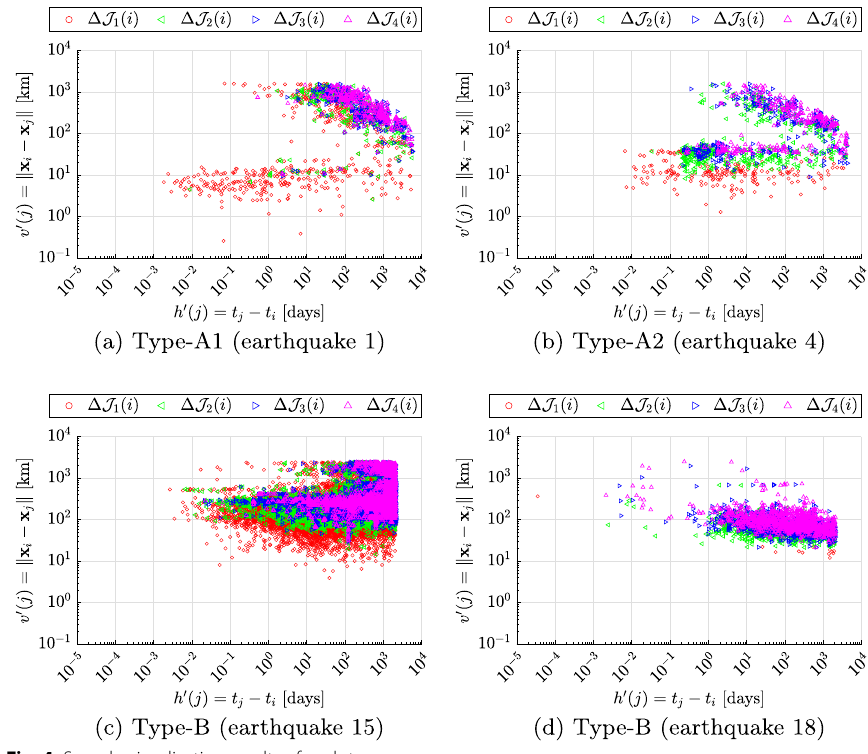
Fig. 4 Sample visualization results of each